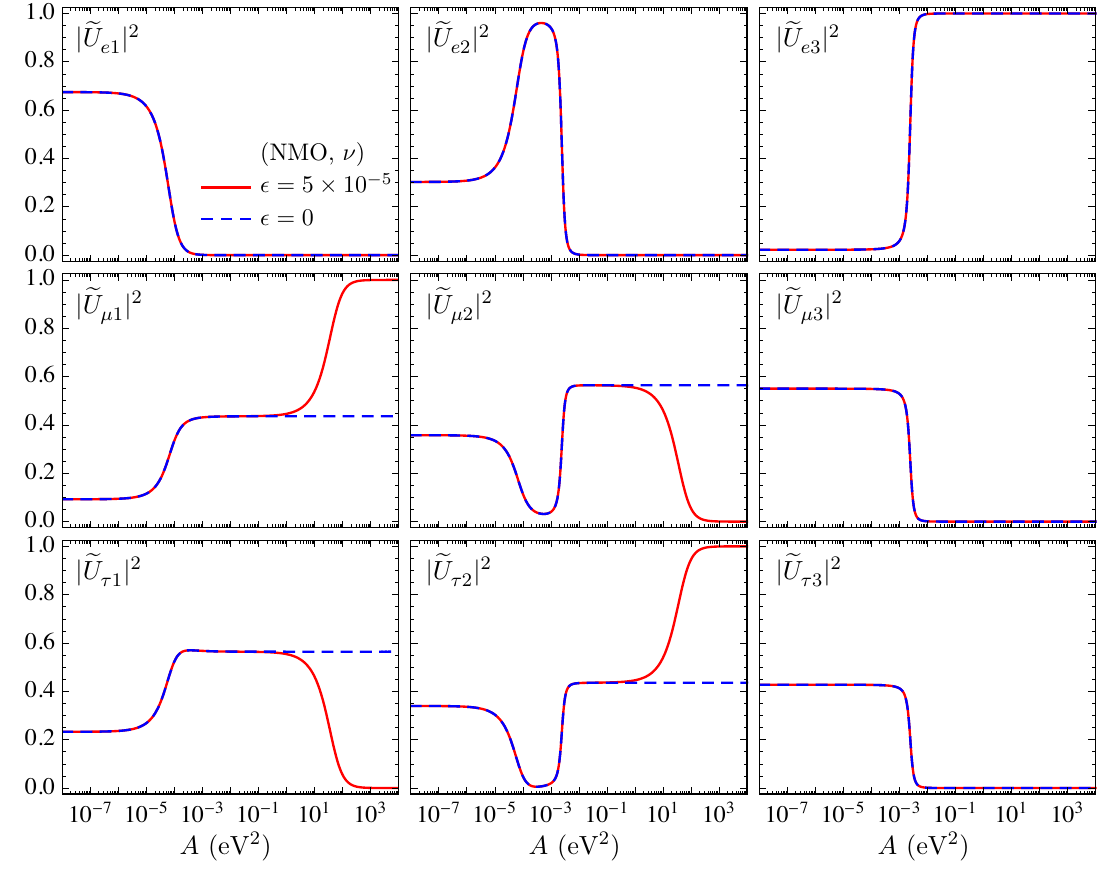
Figure 2 . In the standard three-(cid:13)avor mixing scheme, the illustration of how (cid:22); (cid:28) and i = 1 ; 2 ; 3) evolve with the matter e(cid:11)ect parameter A in the case (NMO ; (cid:23) ) with or without radiative corrections, where the best-(cid:12)t values of ( (cid:18)